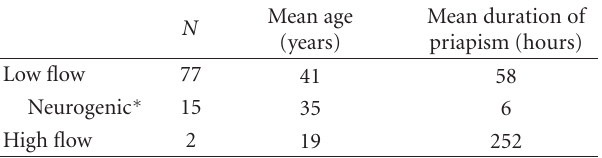
Table 1: Characteristics of priapism. Table 2: Comorbid conditions in patients with low-flow priapism ∗